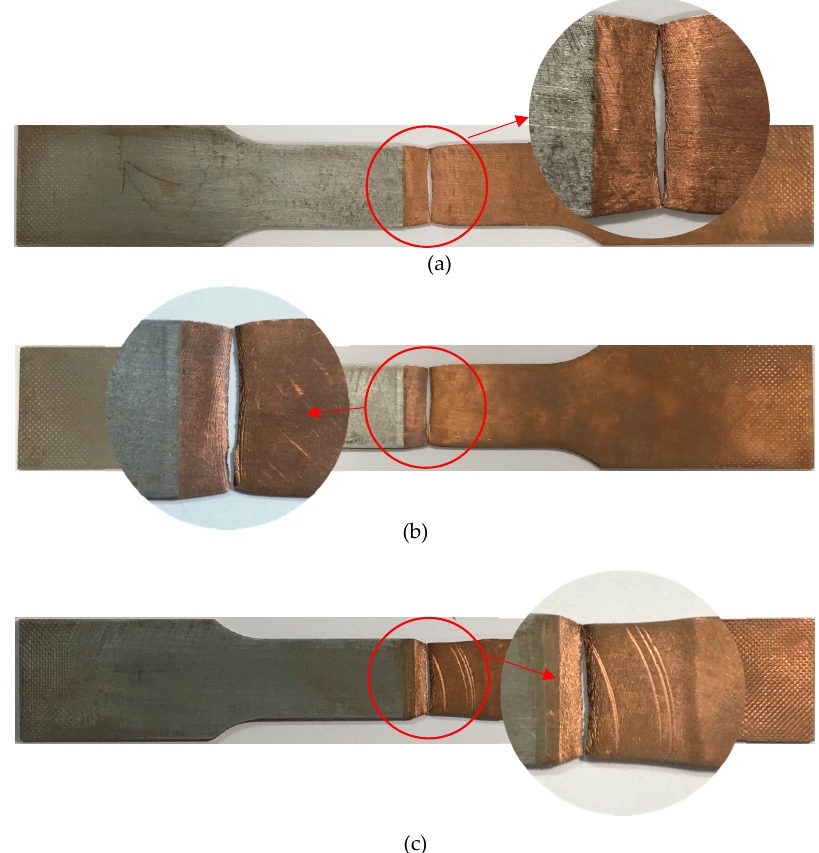
Figure 7. The macroscopic fracture diagrams of the tensile specimens: ( a ) specimen 1, ( b ) specimen 2, ( c ) specimen 3. ( c ) specimen